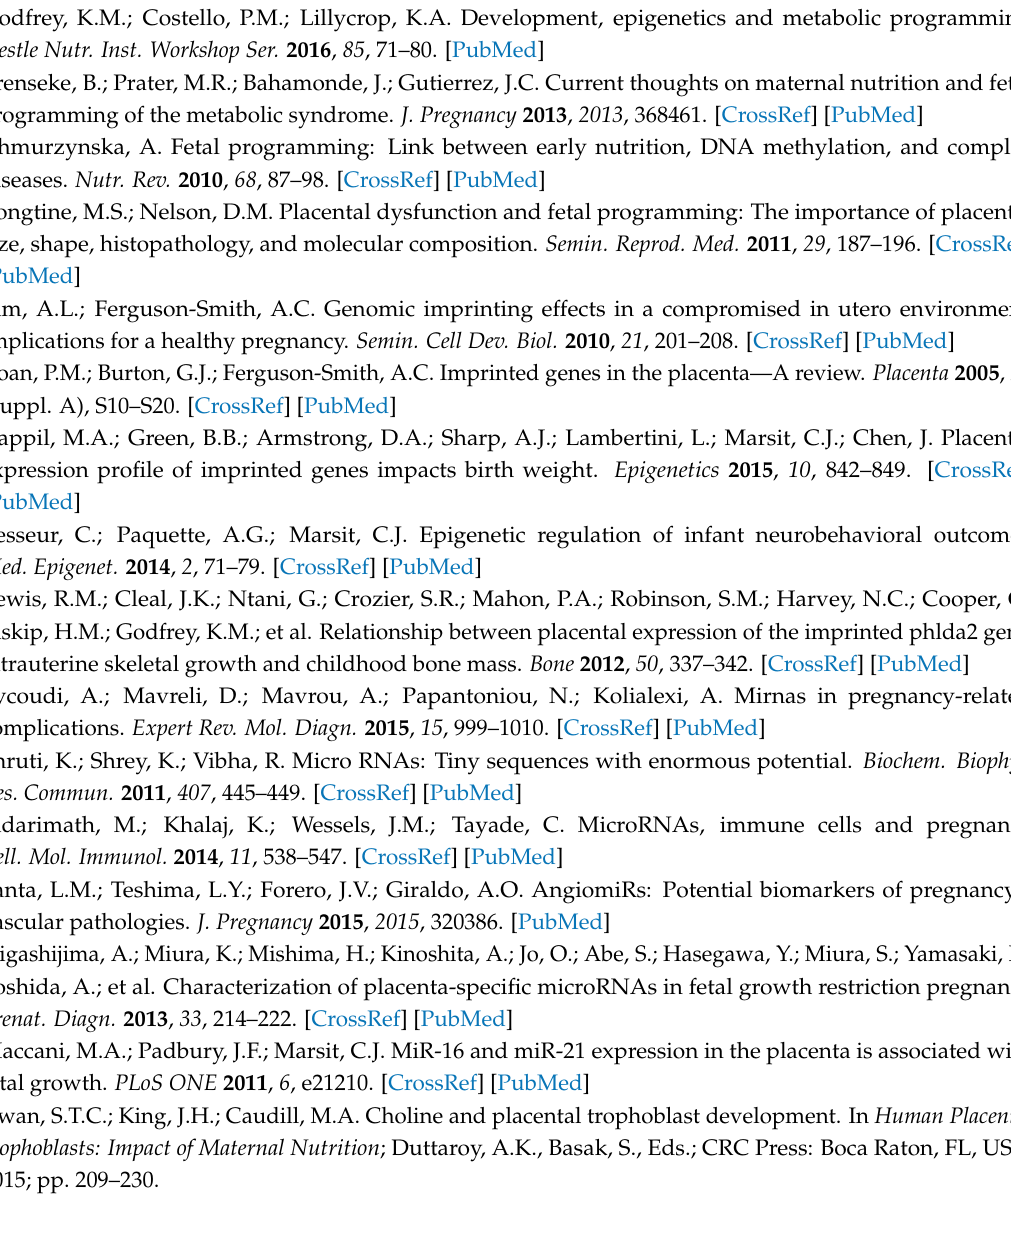
Table S1: Primers for promoter methylation assays and their targeted chromosomal region; Table S2: Selection of CpG units for each imprinted genes for statistical